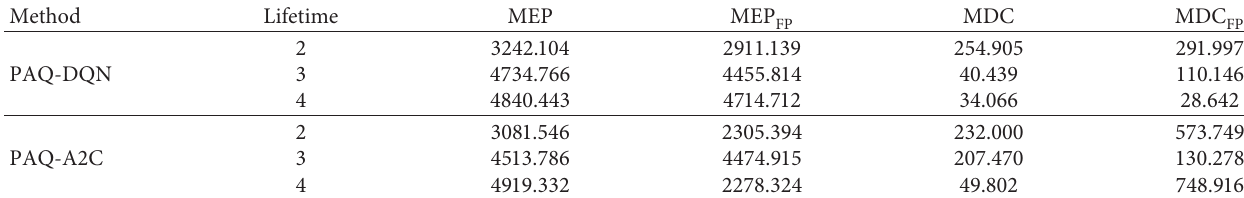
Table 3: Results for dynamic pricing with positive lead time.